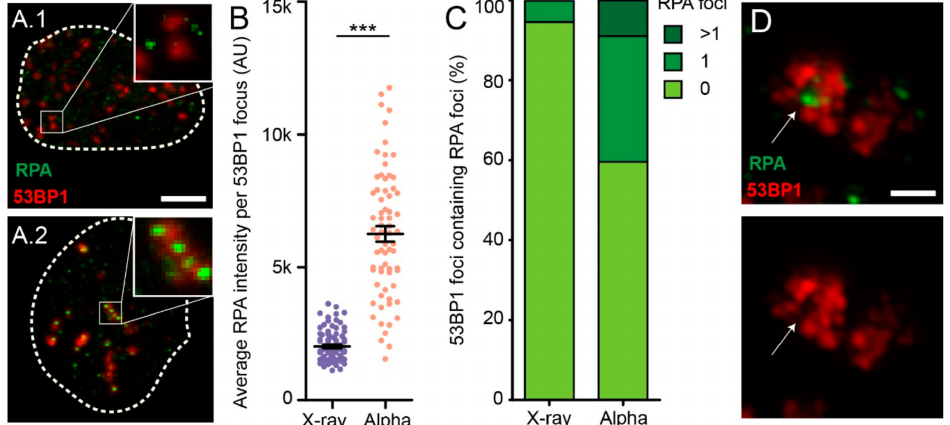
Figure 5. Multiple individual resection events after α -particle irradiation. Representative confocal images of induced 53BP1 and RPA foci by X-ray ( A.1 ) or α -particles ( A.2 ). Scale bar indicates 5 µ m. ( B ) Quantification of RPA focus intensity. ( C ) Percentage of 53BP1 foci colocalizing with 0, 1, or > 1 RPA foci. In total, 15 EdU-positive cells were analyzed using structured illumination microscopy for each treatment. ( D ) Representative images of 53BP1 exclusion at RPA foci after α -particle irradiation. Scale bar indicates 0.8 µ m. Per assay, > 100 EdU positive cells were analyzed. Error bars indicate SEM. The statistical di ff erences are indicated by asterisks (***, p < 0.001) and determined by student’s t